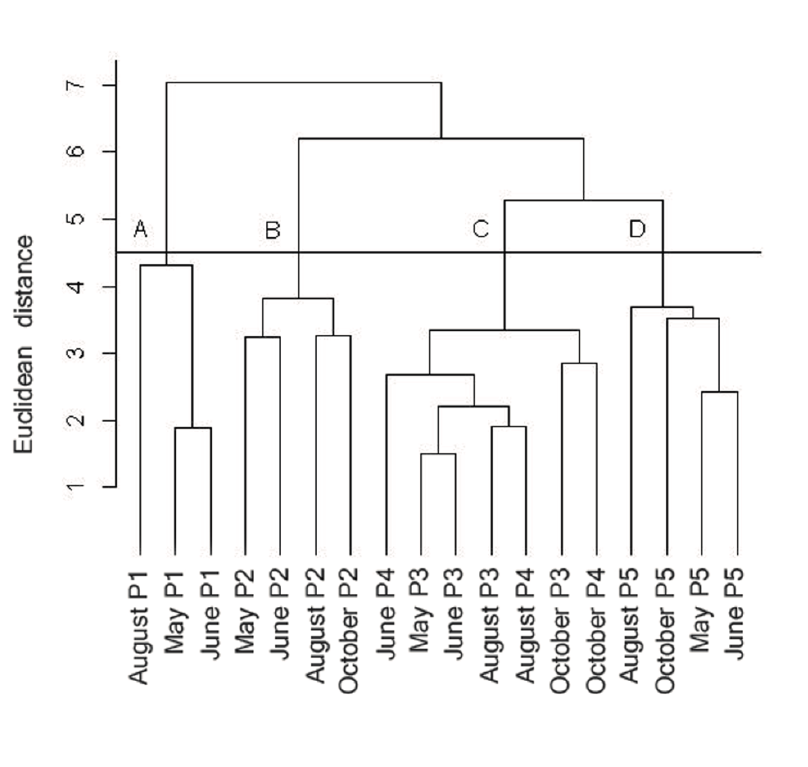
Figure 6. Dendrogram after Cluster analysis from the collected